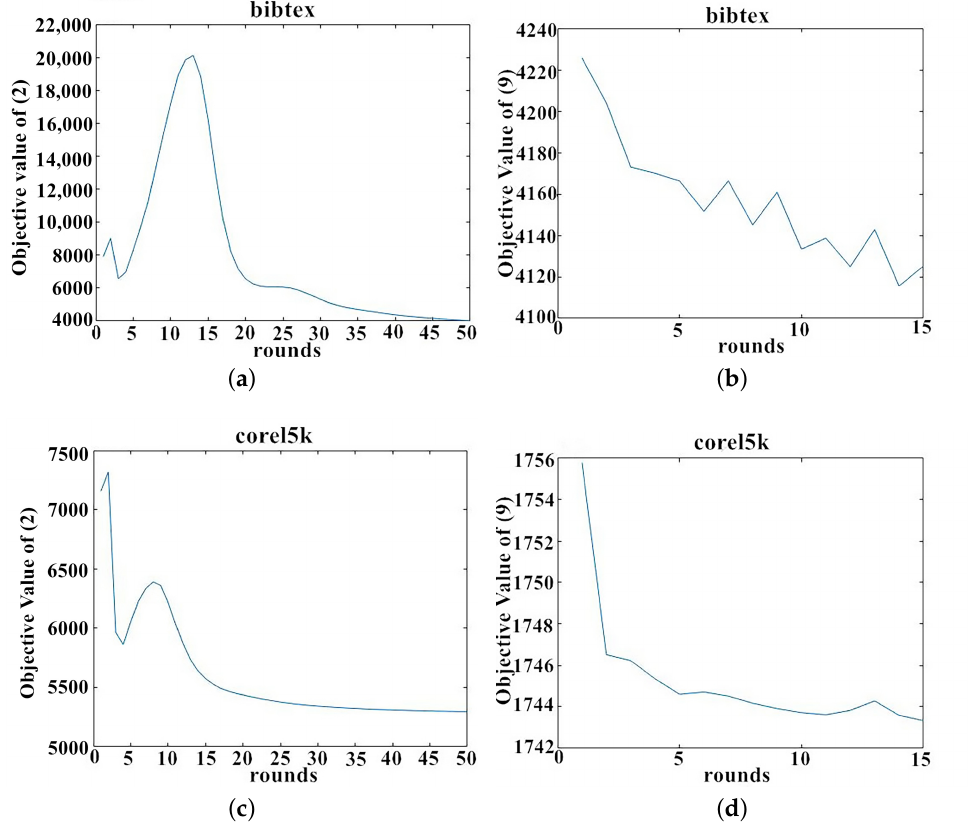
Figure 5. Convergence of RGLC on the bibtex and corel5k datasets with 60% noisy features and missing labels. ( a , c ) are the convergence of (2), whereas ( b , d ) are the convergence of